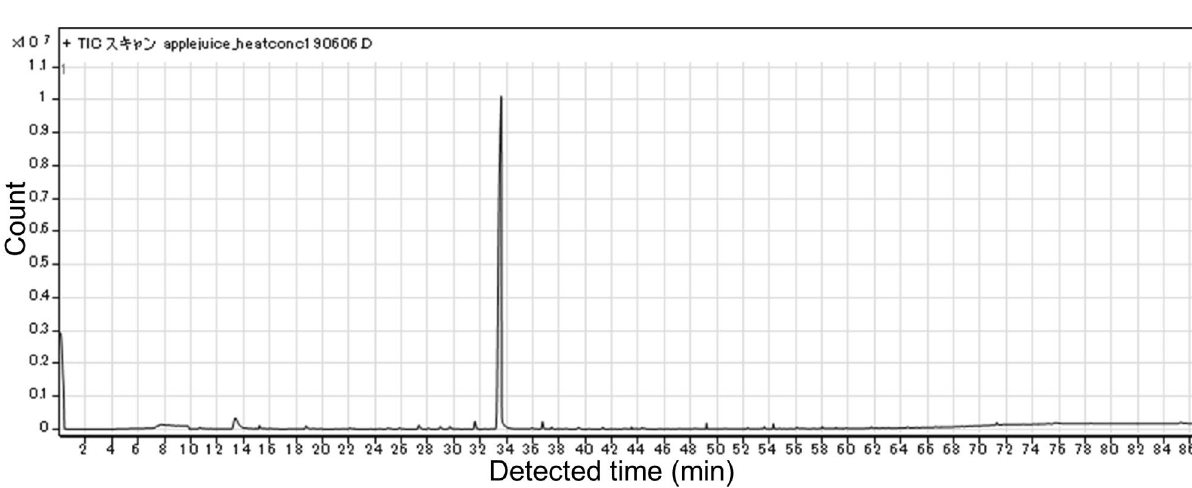
Figure 5. Chromatogram of fresh apple juice.